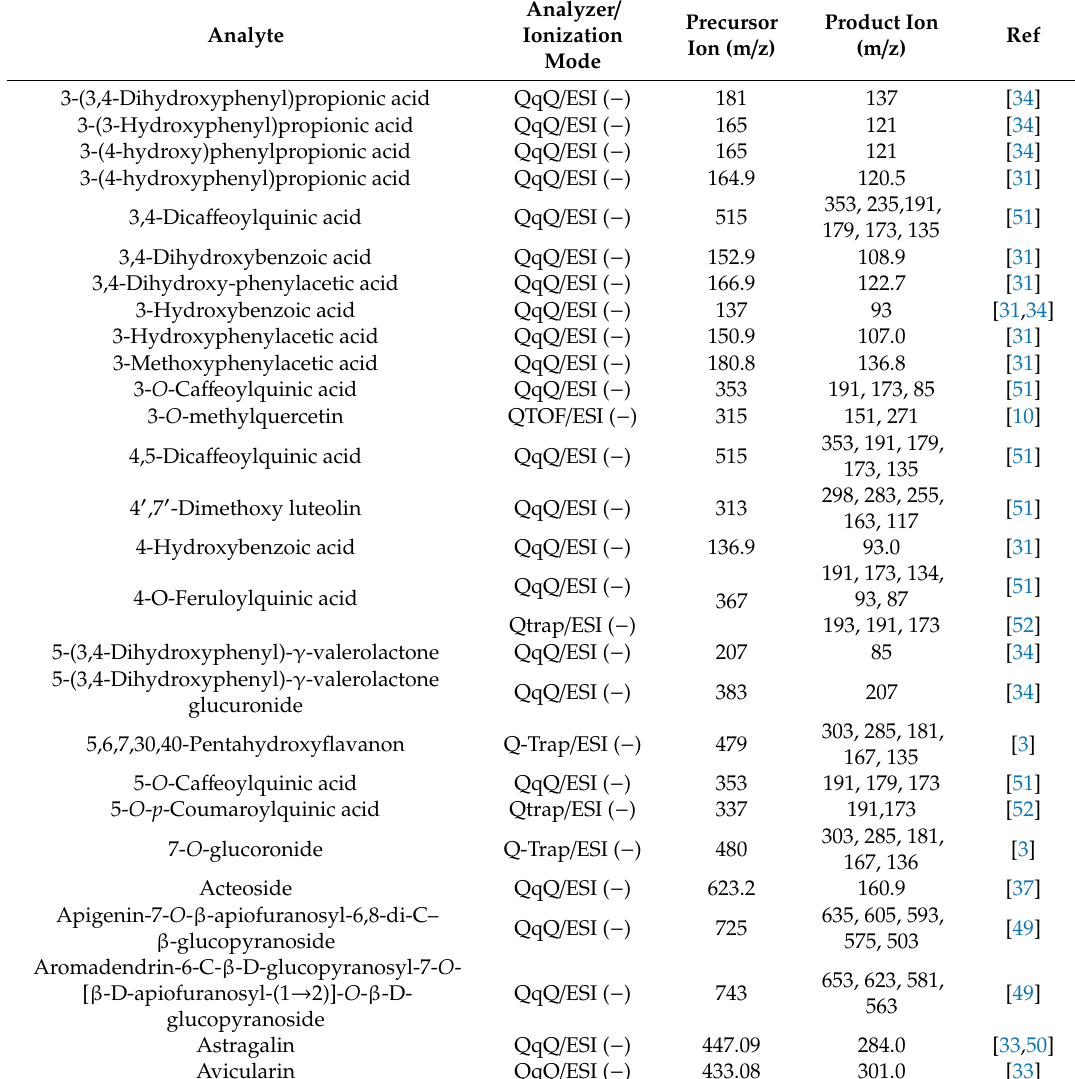
Table 3. Ionization mode, collision energy, and multiple reaction monitoring (MRM) transitions used in the polyphenol